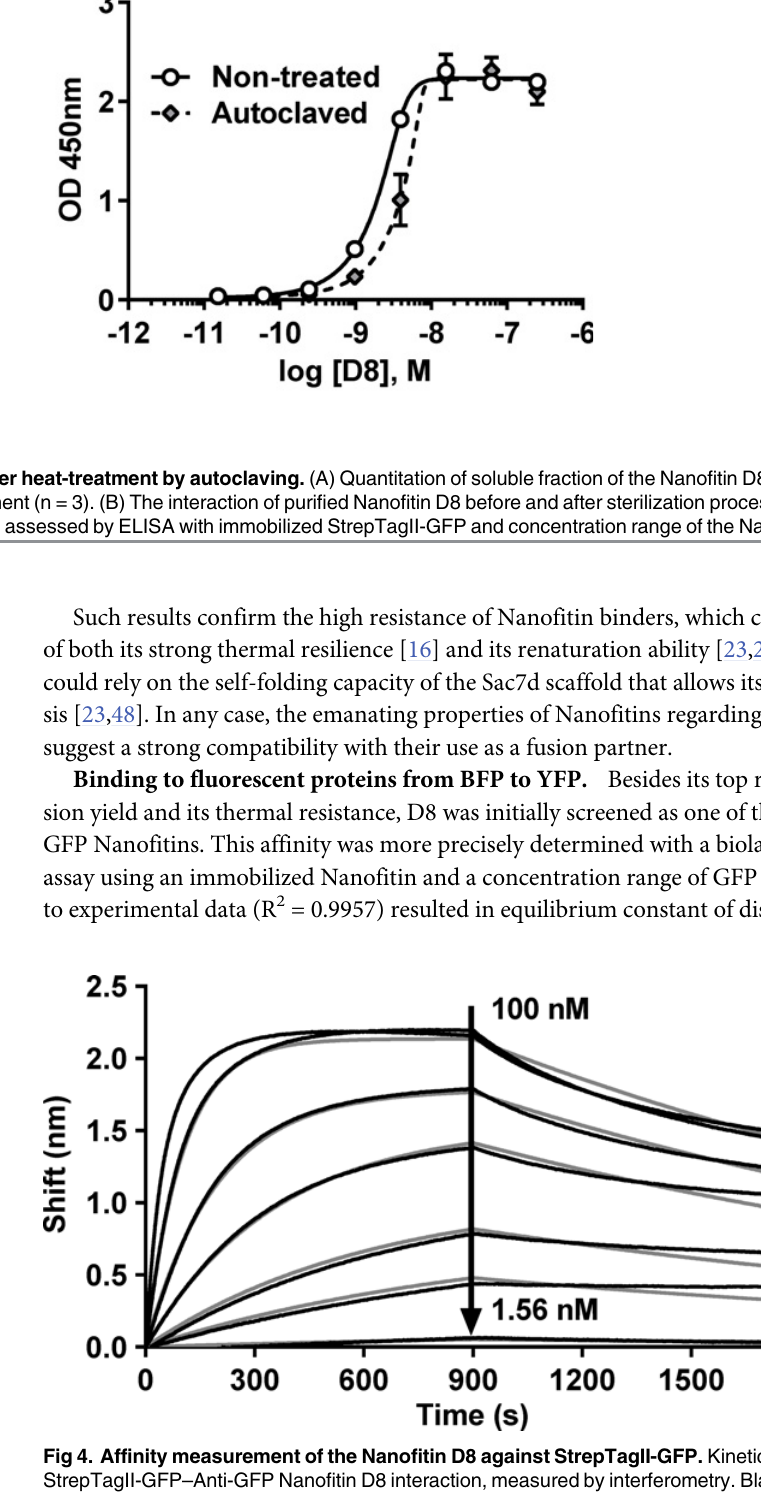
PLOS ONE | DOI:10.1371/journal.pone.0142304 November 5,